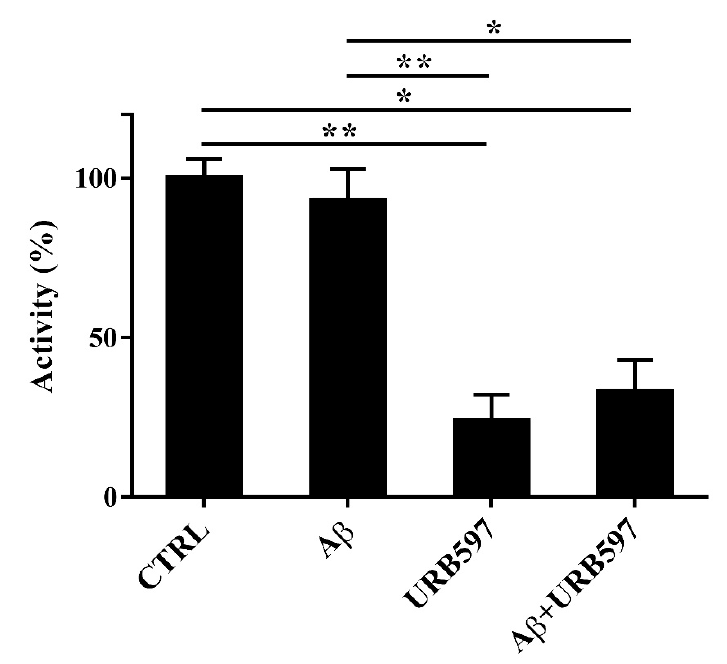
Figure 3. FAAH activity in BV-2 cells pre-treated with 5 µM URB597 for 4 h and incubated with 30 µM A β 25–35 for 24 h. Data are reported as mean ± SEM of three independent experiments. * p < 0.05 , ** p < 0.01 .